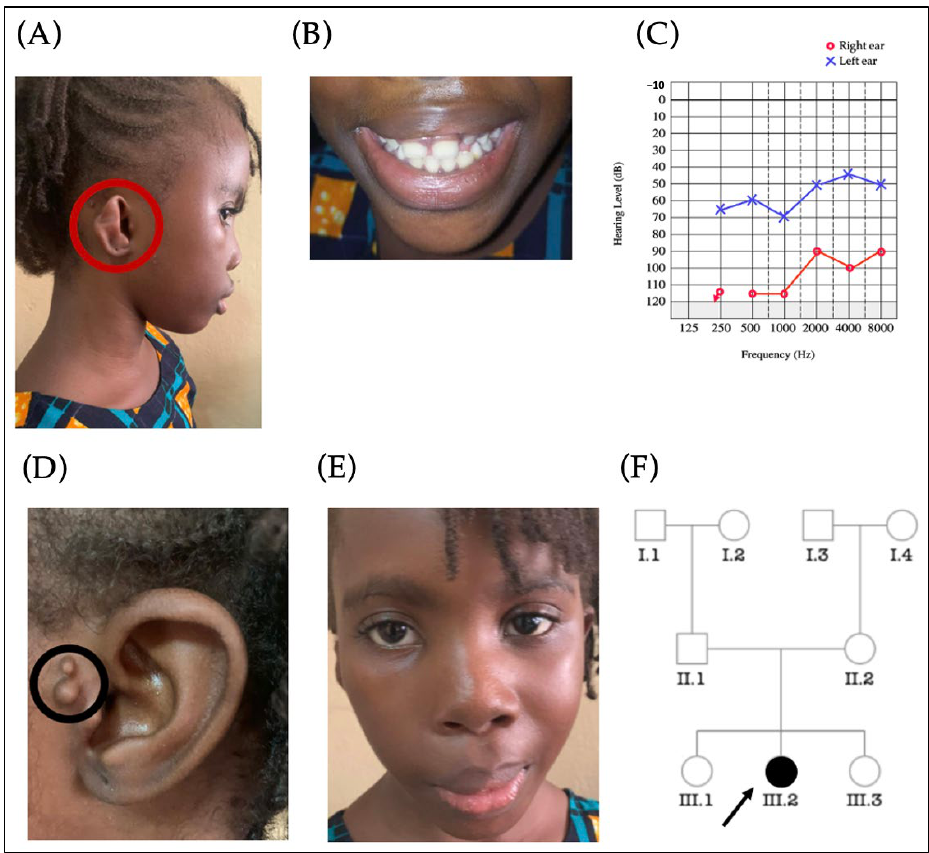
Figure 4. Patient with a suspected Labyrinthine Aplasia, Microtia, and Microdontia syndrome. The photo is illustrating a 7-year-old girl showing unilateral microtia (Type 3) ( A ), microdontia with wide-spaced teeth ( B ), periauricular skin tags ( C ), profound hearing loss in the right ear while the left ear exhibited moderate hearing loss ( D ), and asymmetrical face ( E ). The pedigree ( F ) suggests an autosomal recessive pattern of inheritance. The arrow indicates the proband.